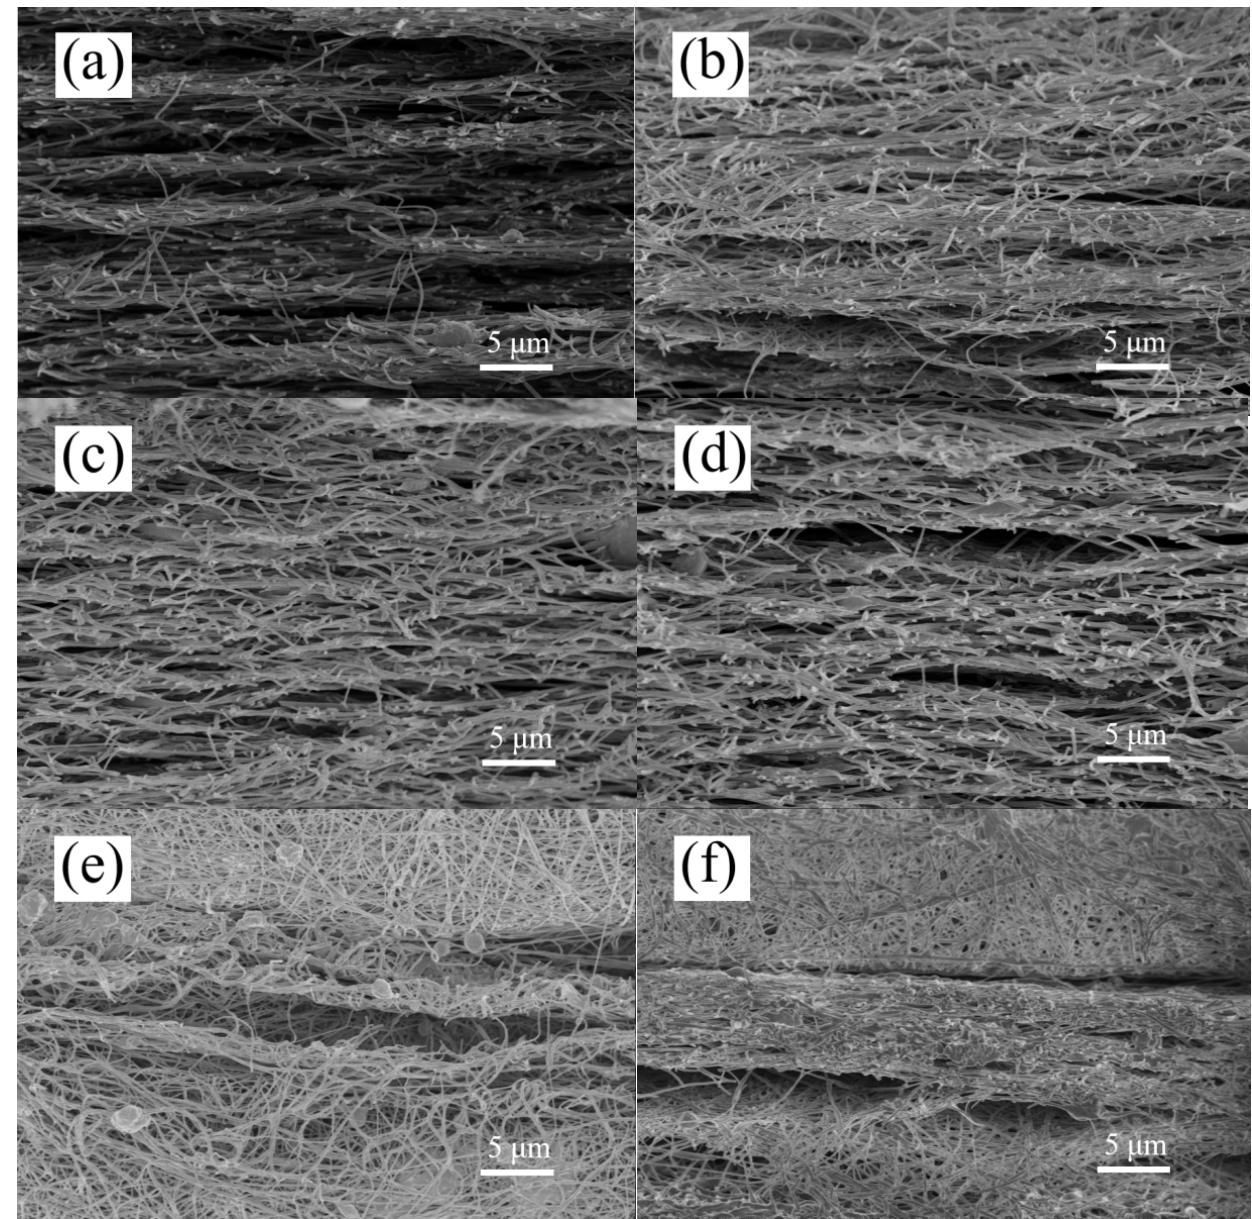
Figure 3. SEM images of the cross-sections of urushiol/PAN nanofilms for different mass ratios: ( a ) Without urushiol (5% PAN), ( b ) 3:5, ( c ) 4:5, ( d ) 5:5, ( e ) 6:5, ( f ) 7:5.